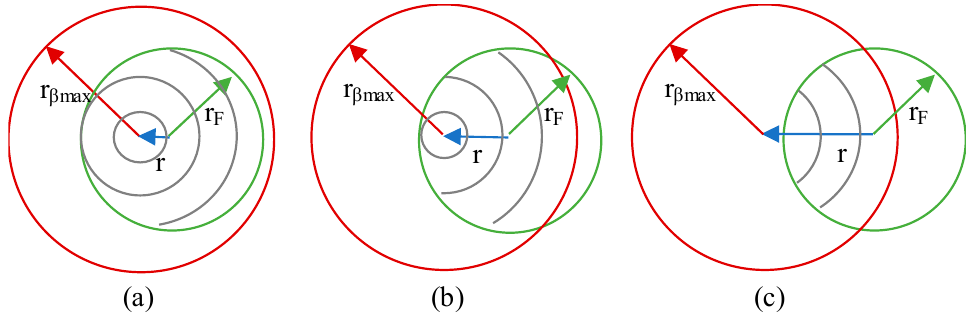
Figure 3. Case I integration sequence as r increases ( a ) only circumferences, ( b ) circumferences and arcs, ( c ) only arcs.